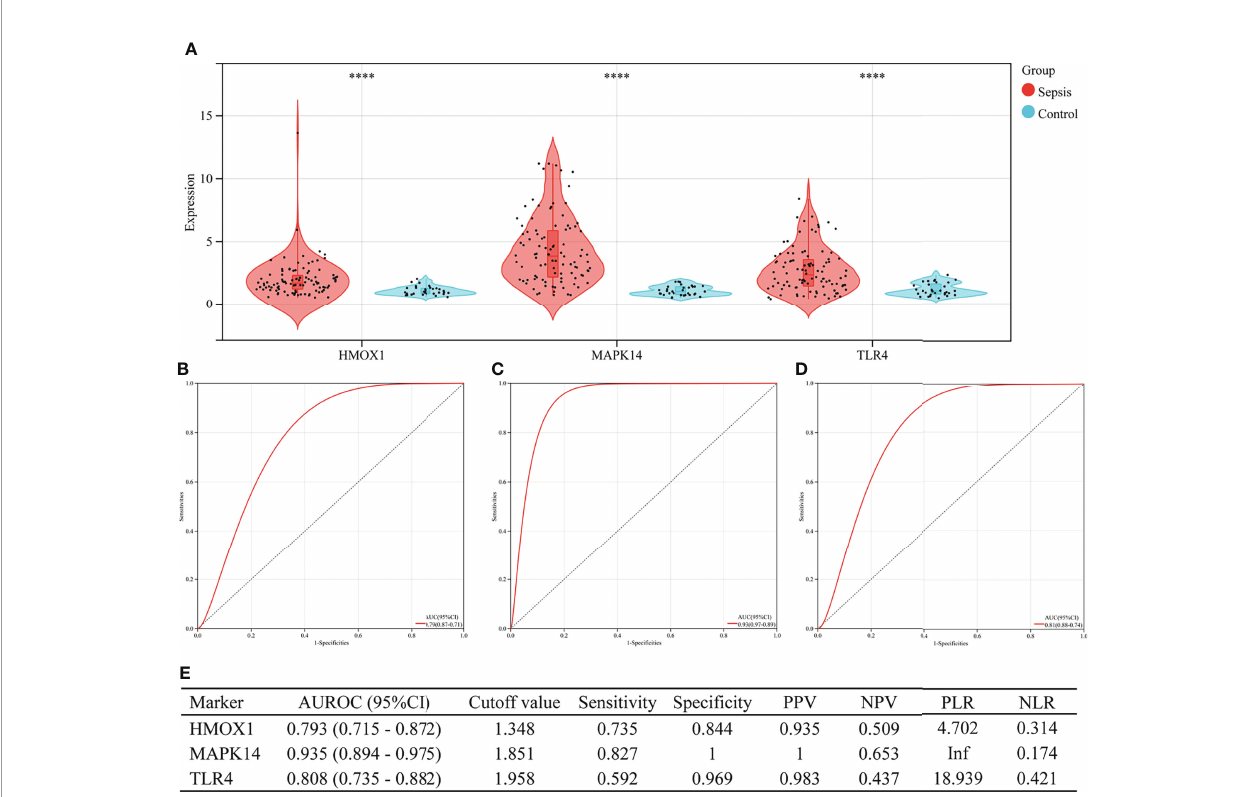
FIGURE 6 | The performance of hub genes to diagnose sepsis in the GSE26440 training set. (A) Expression difference of three hub genes in the sepsis and control groups. (B) The receiver operating characteristic (ROC) curve of HMOX1 gene diagnosis of sepsis. (C) The ROC curve of MAPK14 gene diagnosis of sepsis. (D) The ROC curve of TLR4 gene diagnosis of sepsis. (E) Diagnostic value of three hub genes for differentiating between sepsis and control groups. PPV, positive predictive value; NPV, negative predictive value; PLR, positive likelihood ratio; NLR, negative likelihood ratio; AUROC, area under the receiver operating characteristics curve; CI, con fi dence interval; ****P <